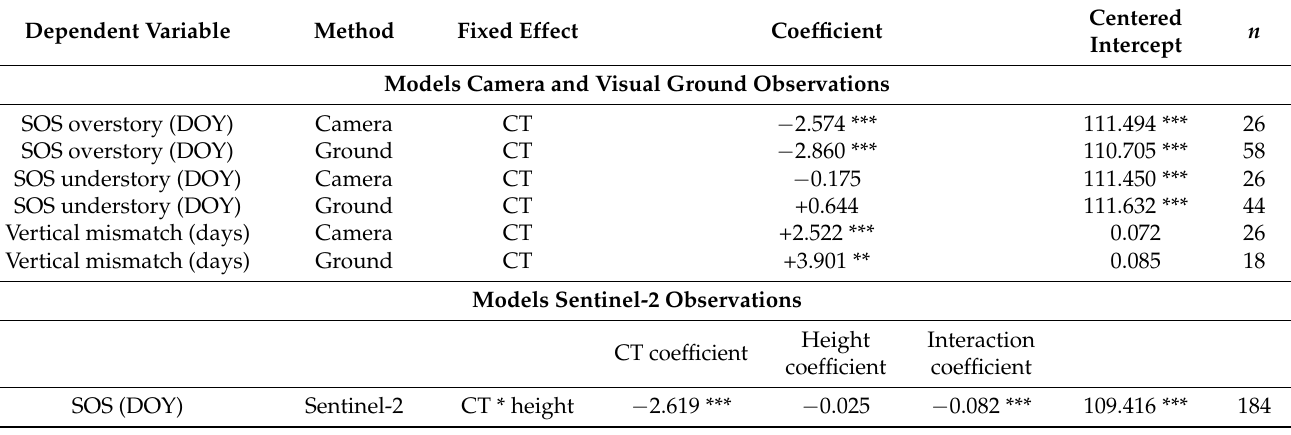
Figure 3. Vertical mismatch between over- and understory (understory SOS–overstory SOS) in depen- dence of the overstory SOS. Circles represent the year 2019, while triangles represent the year 2020. Closed symbols represent camera observations, while open symbols represent ground observations. The same quadrant (ground observations) or the same site (cameras) is always connected by a line (solid for cameras and dashed for ground observations). Table 2. Results of seven separate GLMMs (rows) explaining SOS per layer or vertical mismatch between overstory and understory. Each row represents one model, with the dependent variable listed in the first column, followed by the method in the second column. The third column represents the centered fixed effect. For camera and visual ground observations, that was always canopy temperature (CT). For Sentinel-2 observations, the one model had CT, tree height, and the interaction between CT and tree height (CT × height) as fixed effects. The coefficients represent regression slopes of the fixed effects explaining the dependent variables. Since CT and height are both centered to their means, their centered intercepts are listed for the different models. “n” represents number of trees (see Table 1) × 2 years (for Sentinel-2 and visual ground observations) or number of sites × 2 years (for camera observations). Which random effects are used per model is described in the methods. Stars indicate